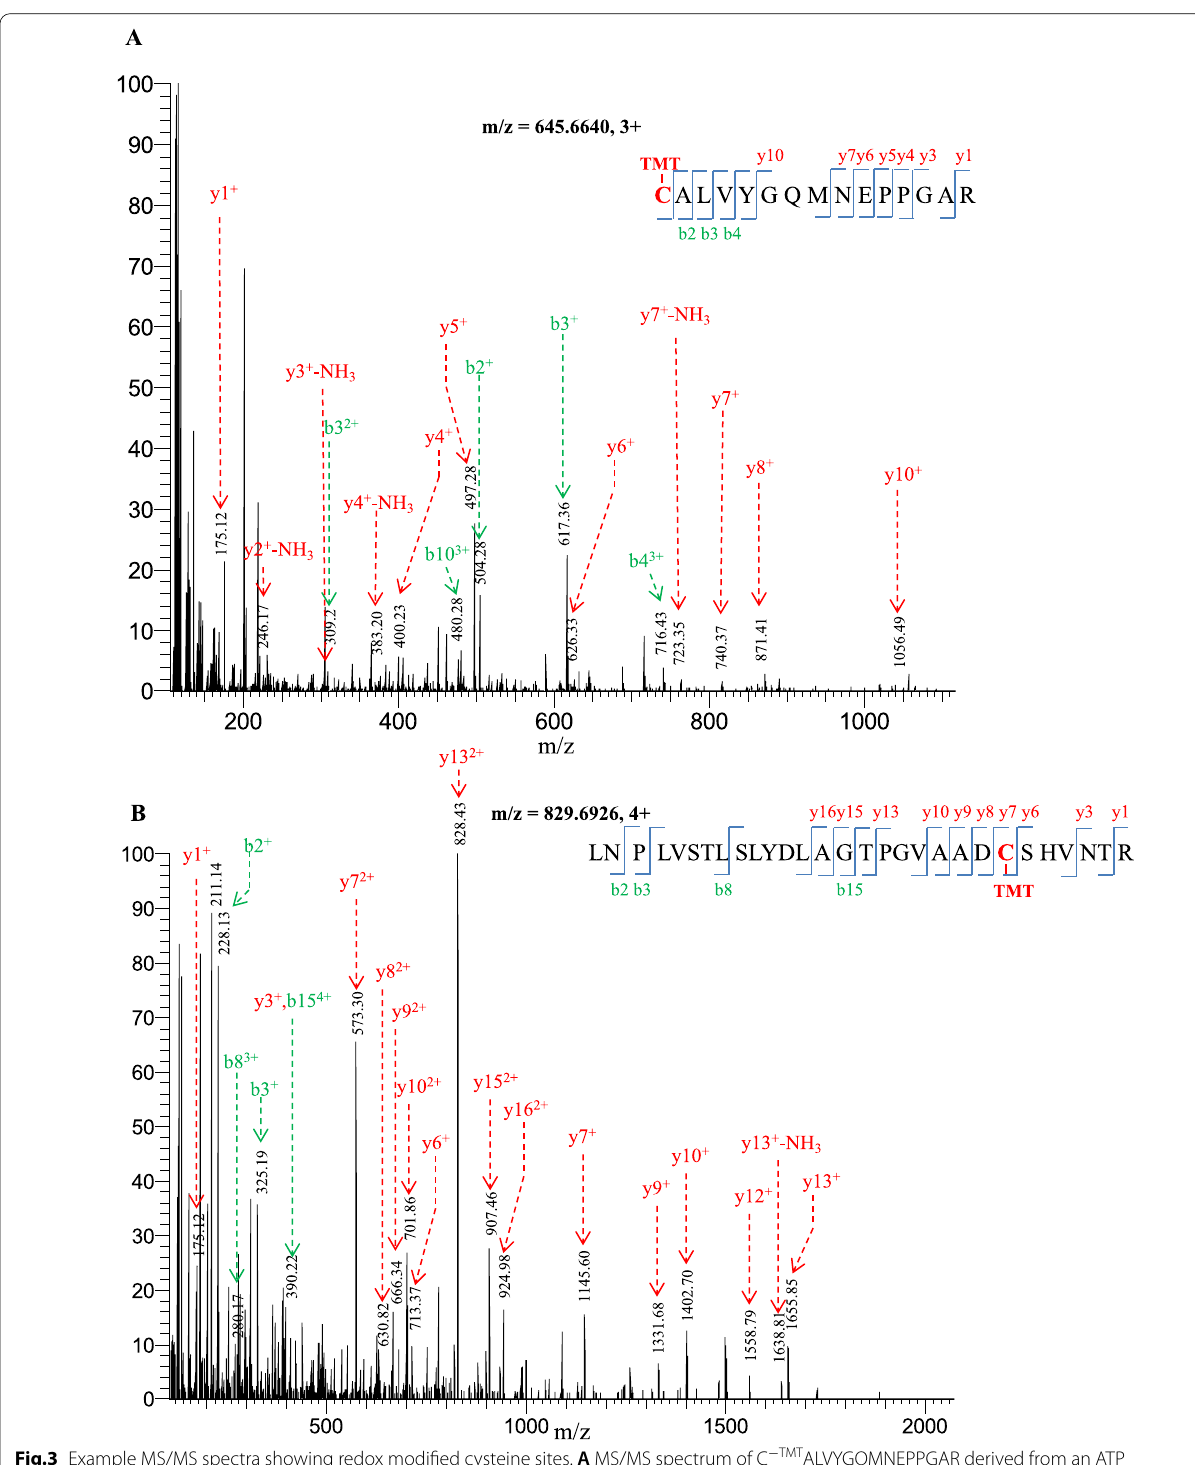
Fig.3 Example MS/MS spectra showing redox modified cysteine sites. A MS/MS spectrum of C − TMT ALVYGQMNEPPGAR derived from an ATP synthase B MS/MS spectrum of LNPLVSTLSLYDLAGTPGVAADC − TMT SHVNTR derived from a malate